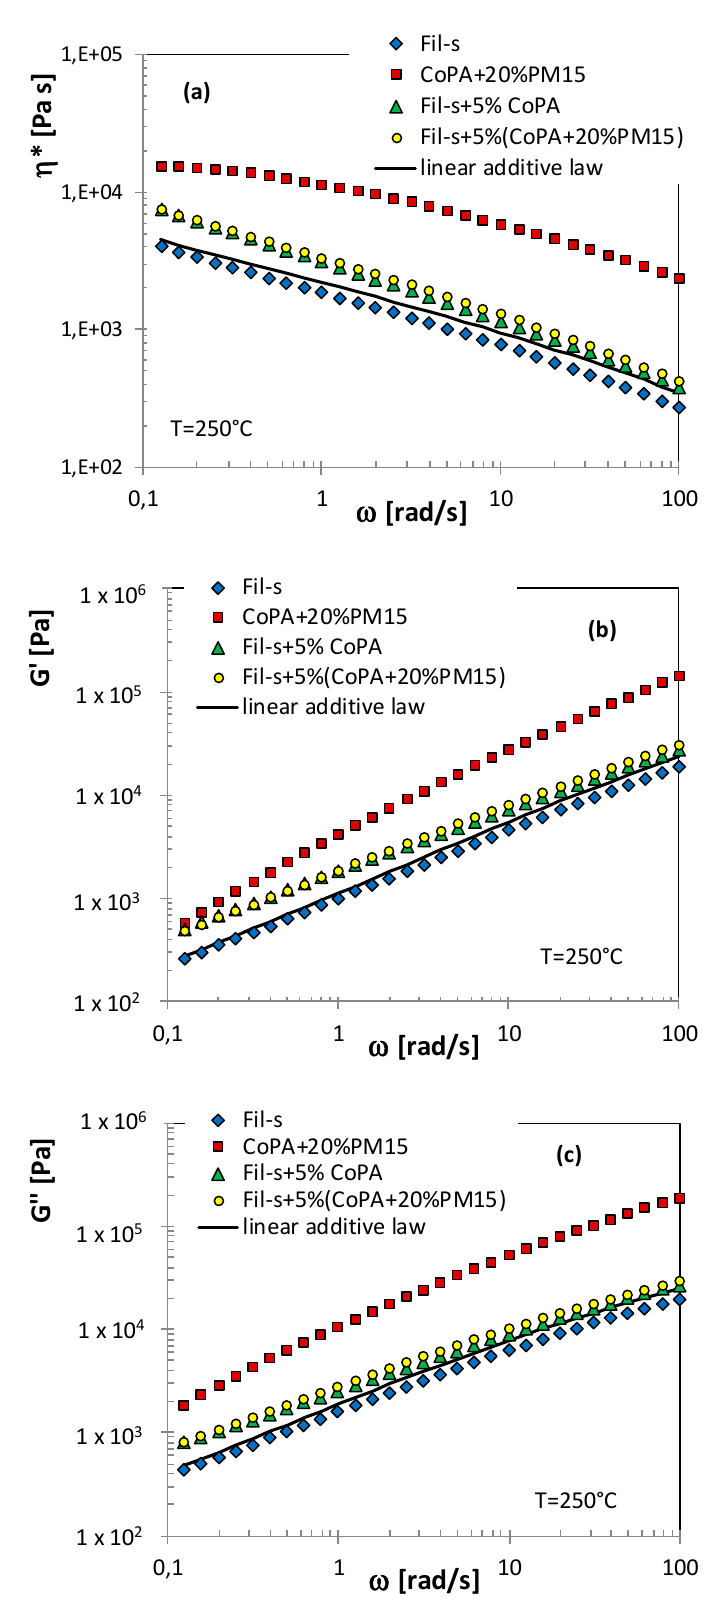
Figure 6. Comparison of the dynamic viscoelastic properties of Fil-s, the nanocomposite copolyamide masterbatch, and their blend; the solid lines represent the blend properties as predicted by a simple linear additive law: ( a ) complex viscosity; ( b ) storage modulus; and ( c ) loss modulus.